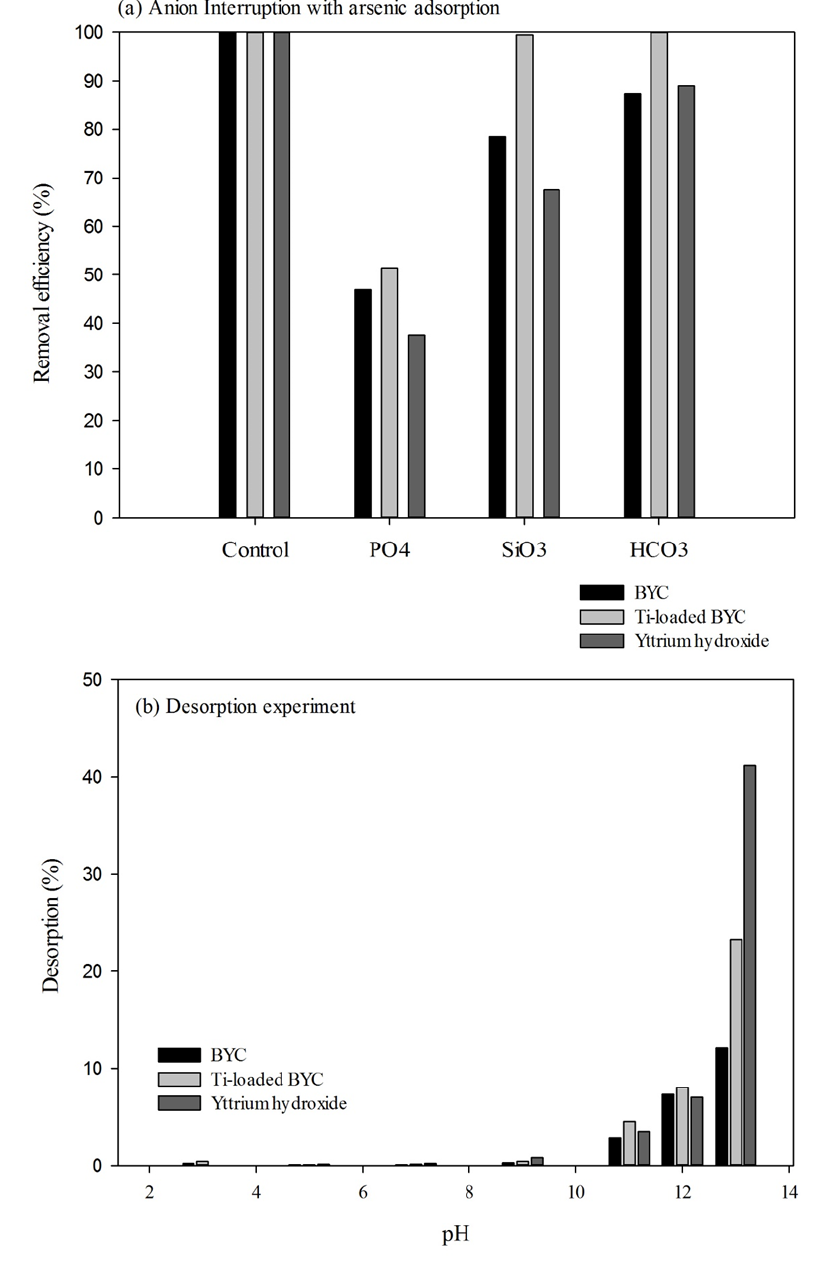
Figure 8. Anionic co-ion effect ( a ) and desorption results ( b ) by the adsorbents (condition ( a ); arsenic concentration: 10 mg/L, anion concentration: 10 mg/L, dose: 0.1 g/L, temperature: 298K, reaction time: 24h, condition ( b ); dose: 1 g/L, temperature: 298K, reaction time;